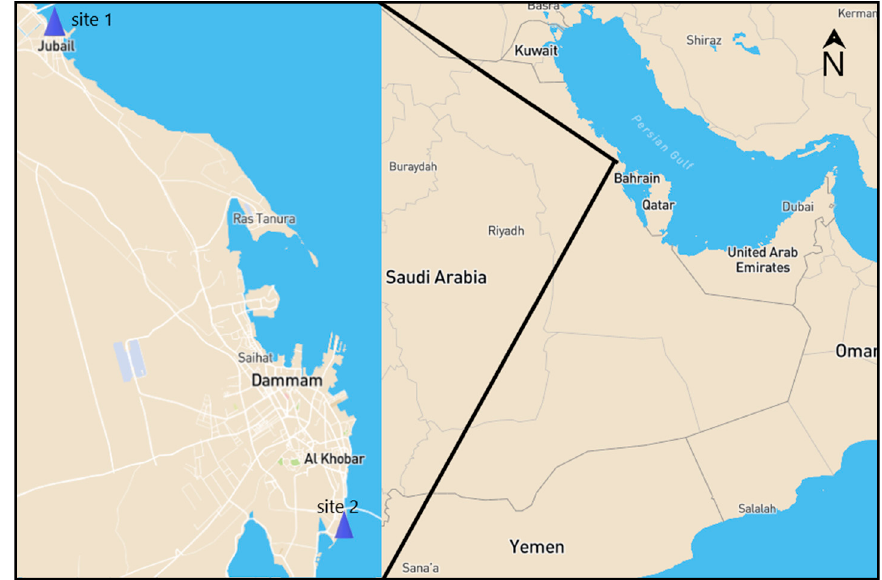
Figure 1. Beach well drilling site #1 within the Jubail Saline Water Conversion Corporation (SWCC) facility, and beach well drilling site #2 within the Al-Khobar SWCC facility in the Kingdom of Saudi Arabia (KSA).